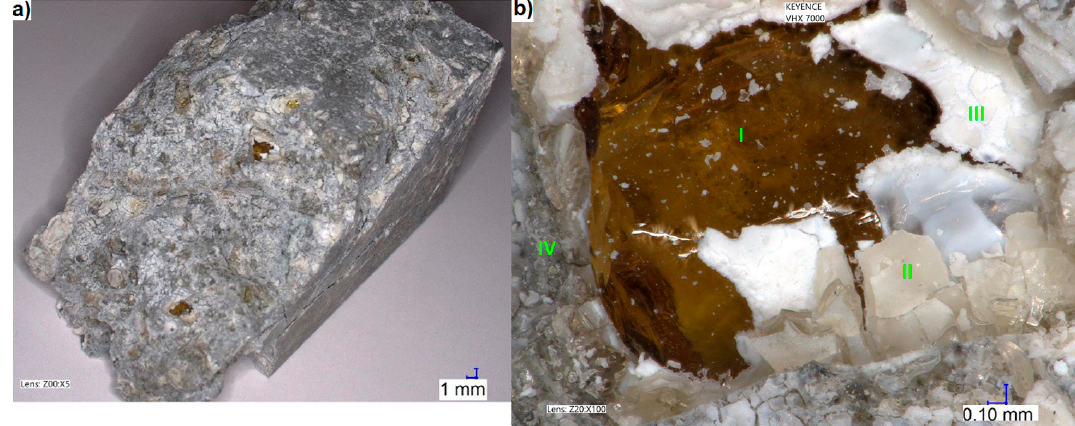
Figure 2. Cracked mortar specimens at 107 days of immersion in NaOH